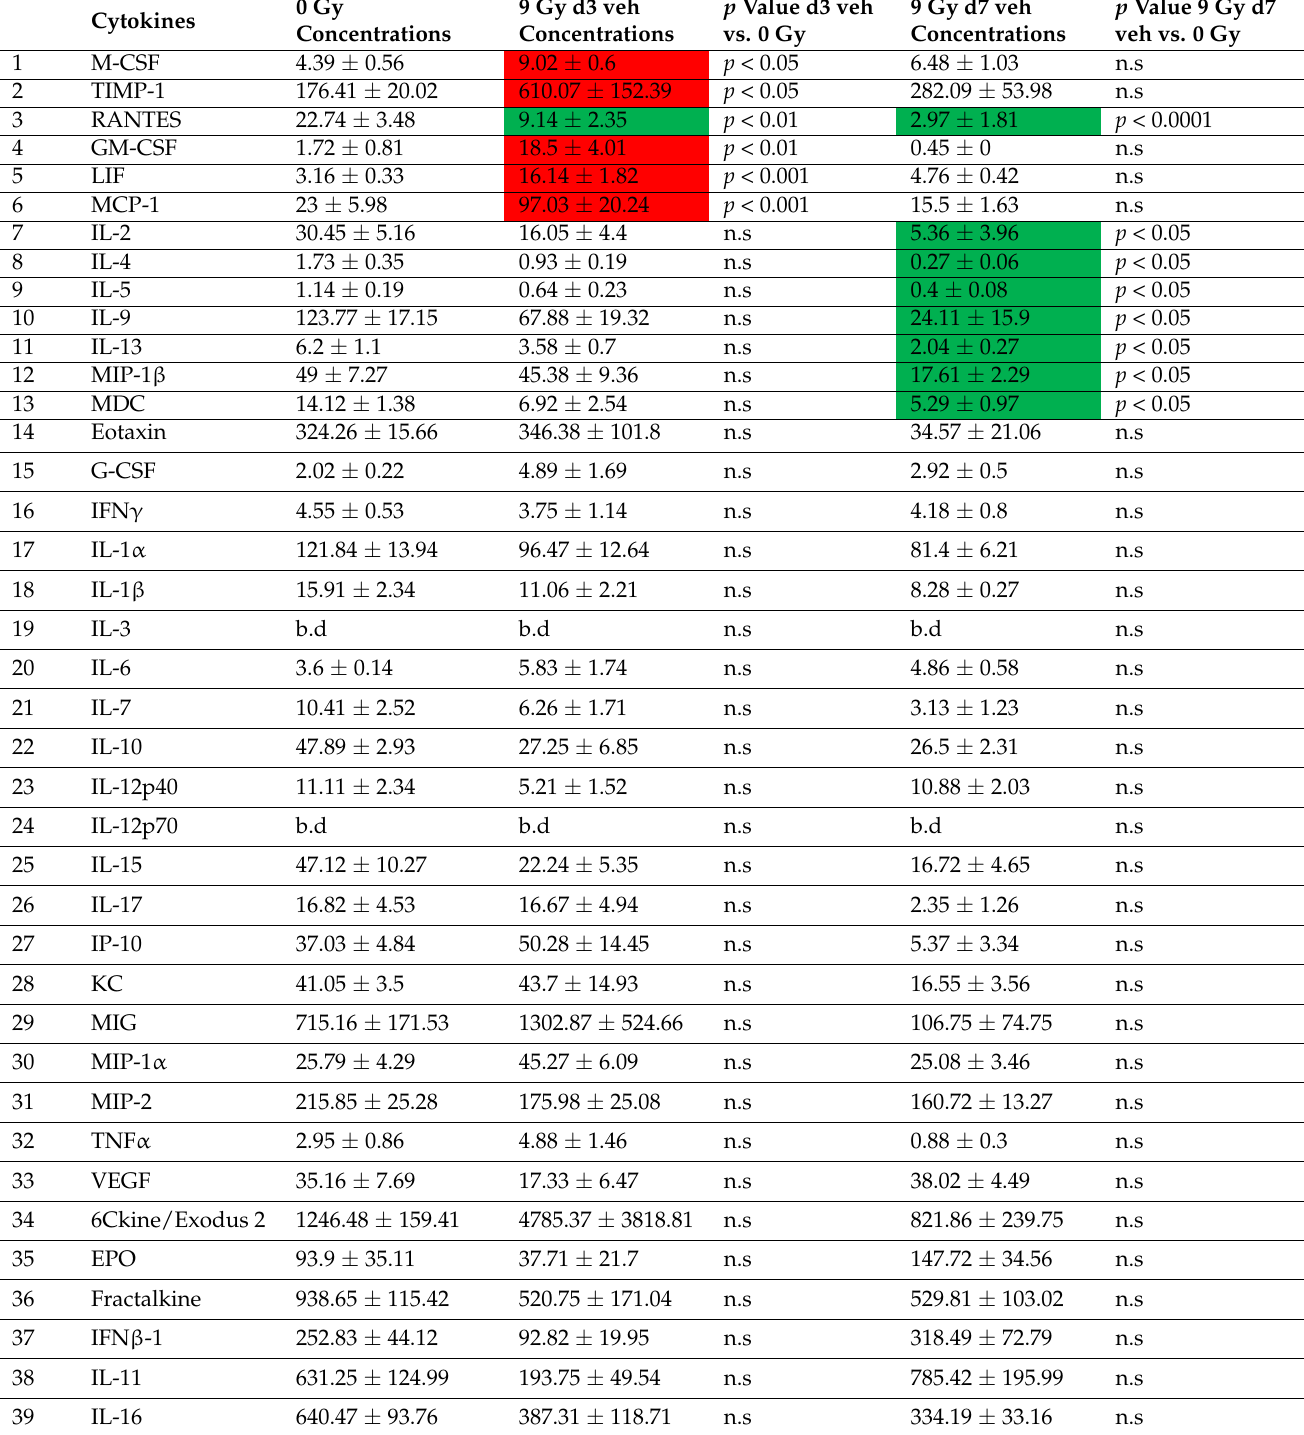
Table 2. Intestinal cytokine changes after 9.0 Gy TBI in CD2F1 mice. Intestinal cytokine levels at d3 and d7 after irradiation with vehicle treatment were compared to the 0 Gy controls. All cytokines’ concentration unit was pg/mL. Mean ± standard error of mean (SEM) were shown for each cytokine. Red color represented significantly elevated cytokines and green color represented significantly decreased cytokines. n.d, non-detectable. n.s, non significant. N = 5–6 mice/group. p < 0.05 is considered significantly changed. Mouse intestinal cytokine changes after 9